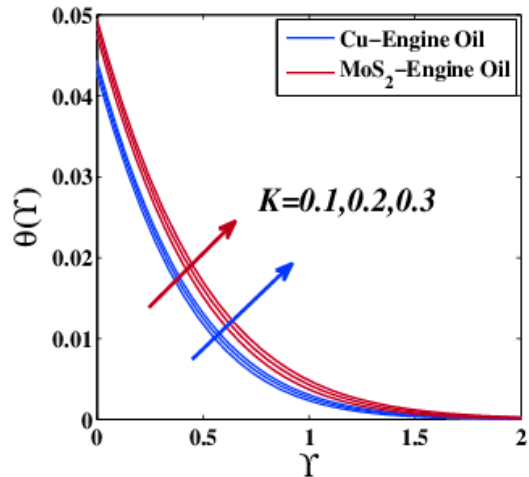
Figure 11. Temperature variation θ ( Y ) under the influence of K .